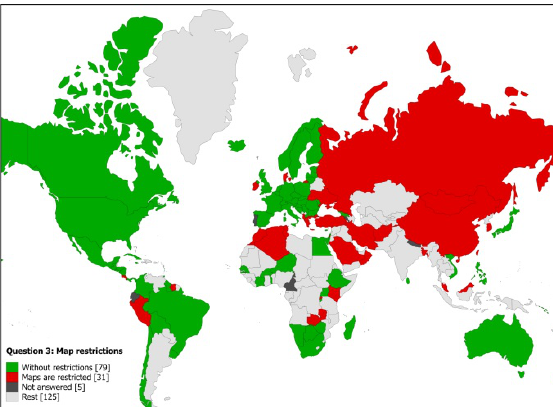
Figure 3: Map coverage at scale 1:50 000